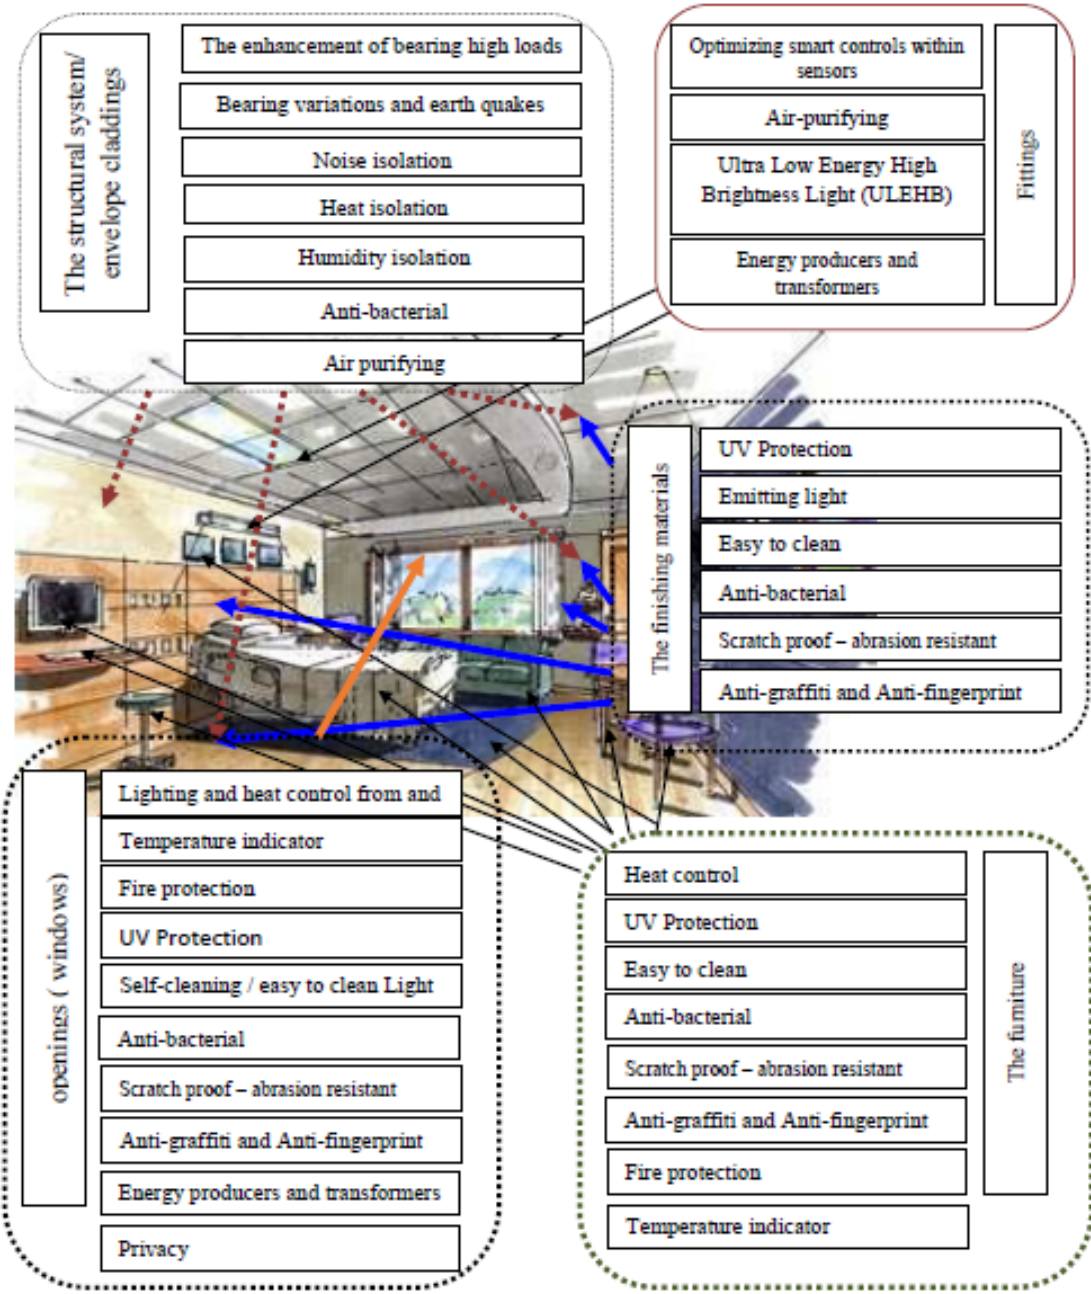
Figure 16. shows the afforded intelligent materials in the patient